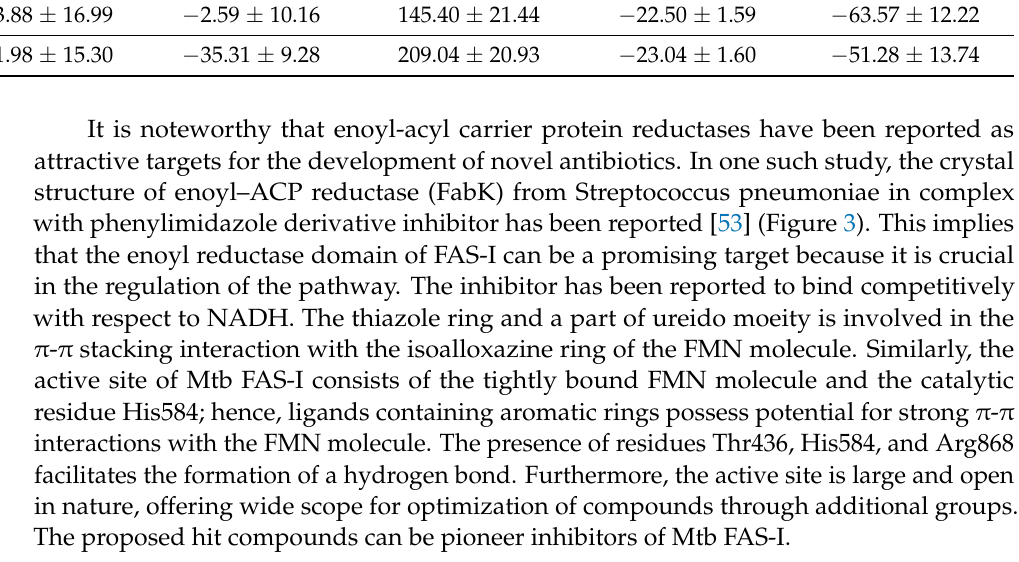
Figure S2: The r.m.s.d plots shown for FMN molecule and protein backbone